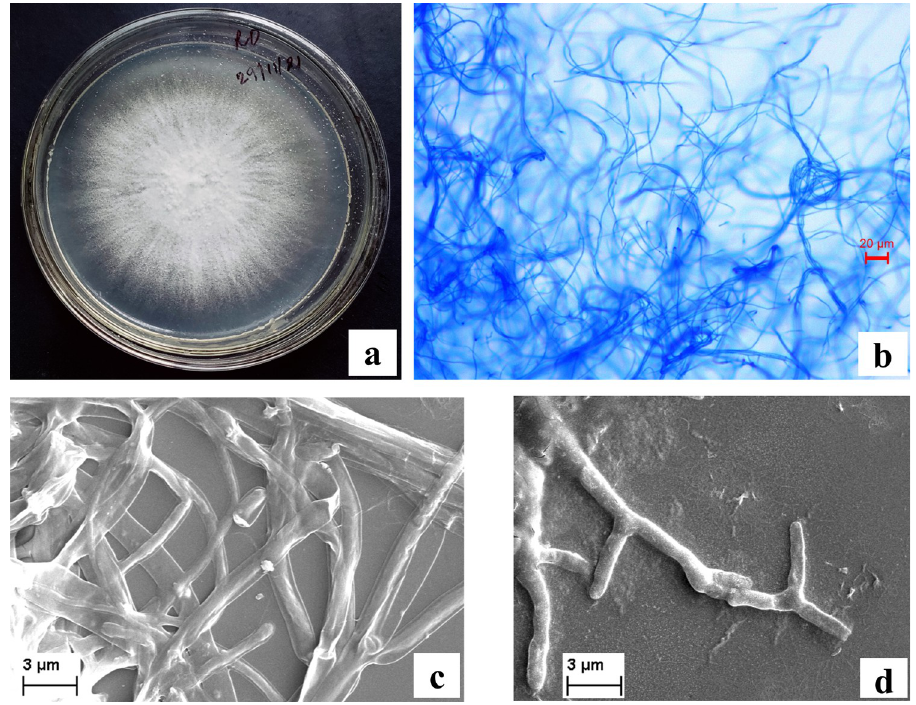
Fig 1. 10 days old culture of Colletotrichum alatae LCS1 (A), Light microscopic image of sterile mycelium (B), Scanning electron micrograph of sterile hyphae (C-D).